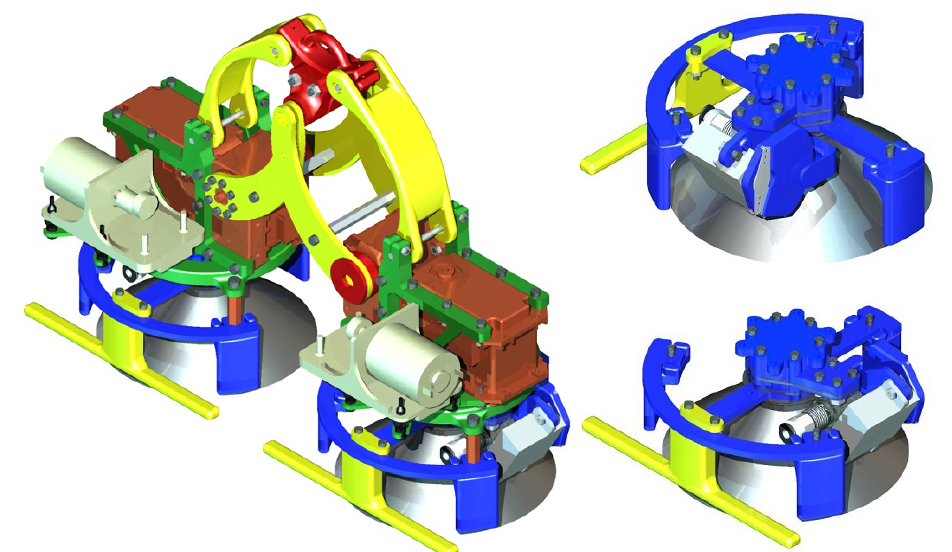
Figure 3. CAD design of the robot. Each foot unit includes a cleaning unit, a suction cup, a vacuum pump, a seal mechanism, a valve to break vacuum, and servo motors for joint actuation. The robot installs a parallel linkage mechanism to keep the foot unit of the system and the glass surface parallel without any control system.